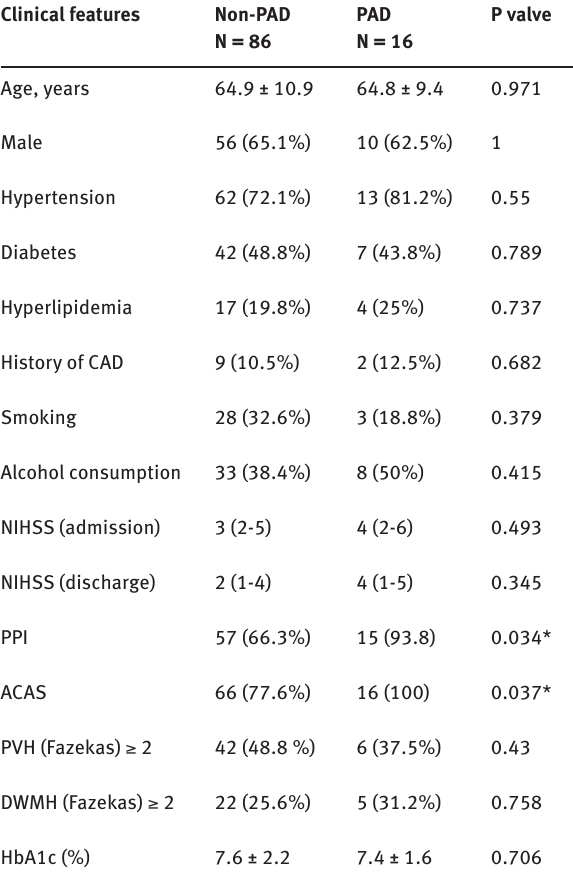
Clinical features